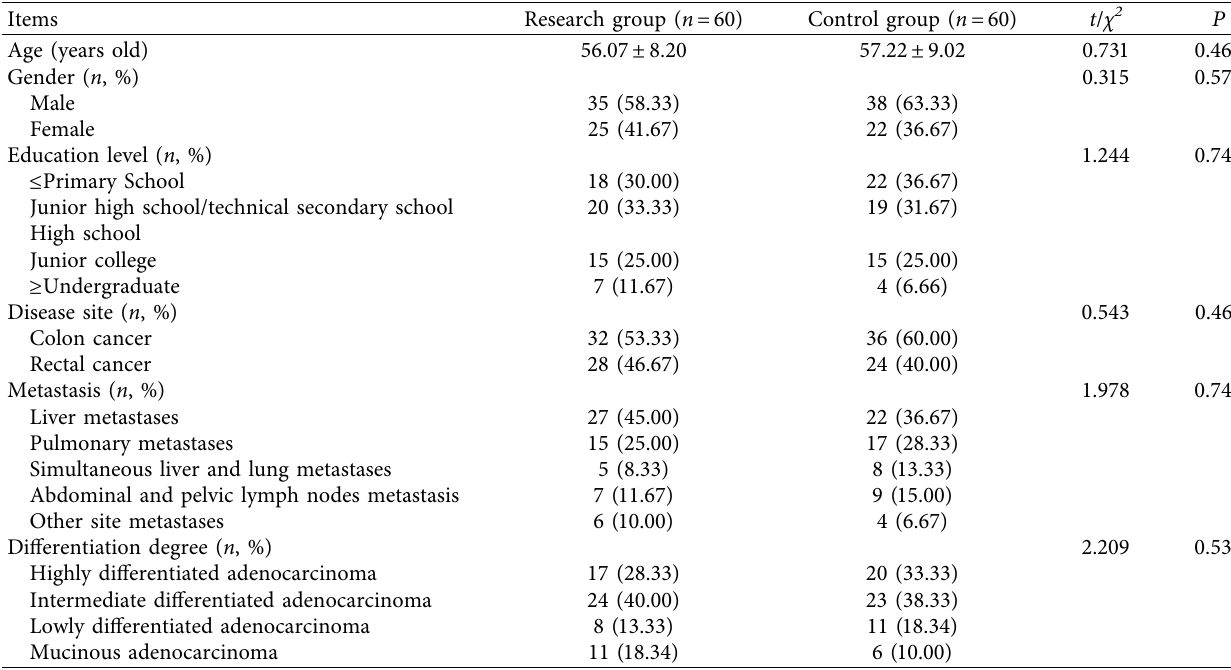
Table 3: Comparison of general items for both